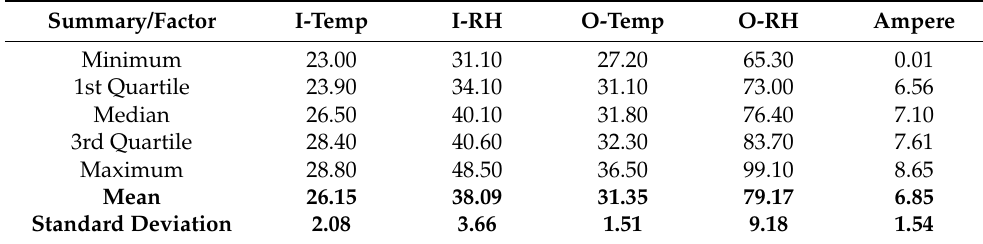
Table 6. Summary of worst airflow